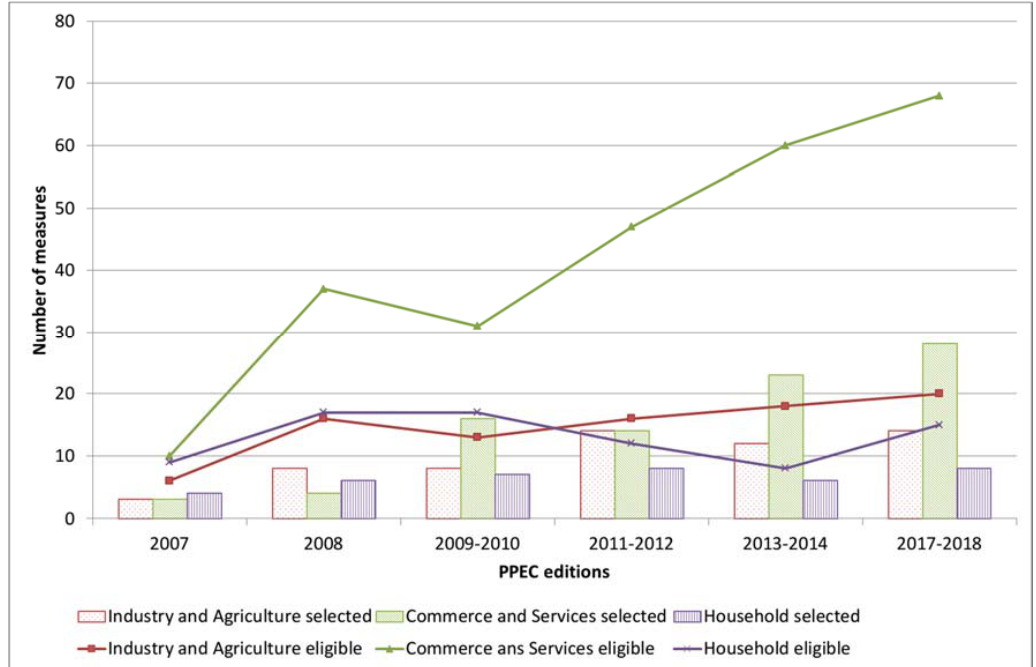
Figure 5. Number of eligible and selected measures by consumer segment in each PPEC edition [19–26].